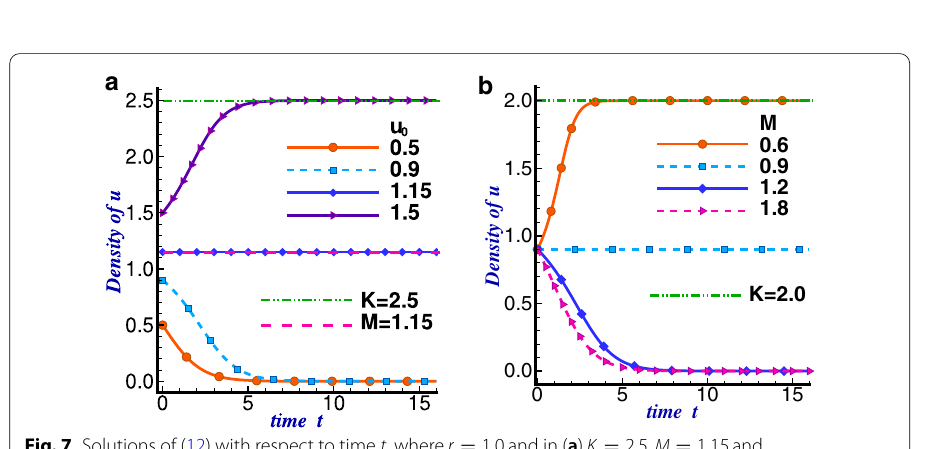
0.5 and r 2.5 , u 0 = = 1.5,1.0,0.5,0.2,0.1 =